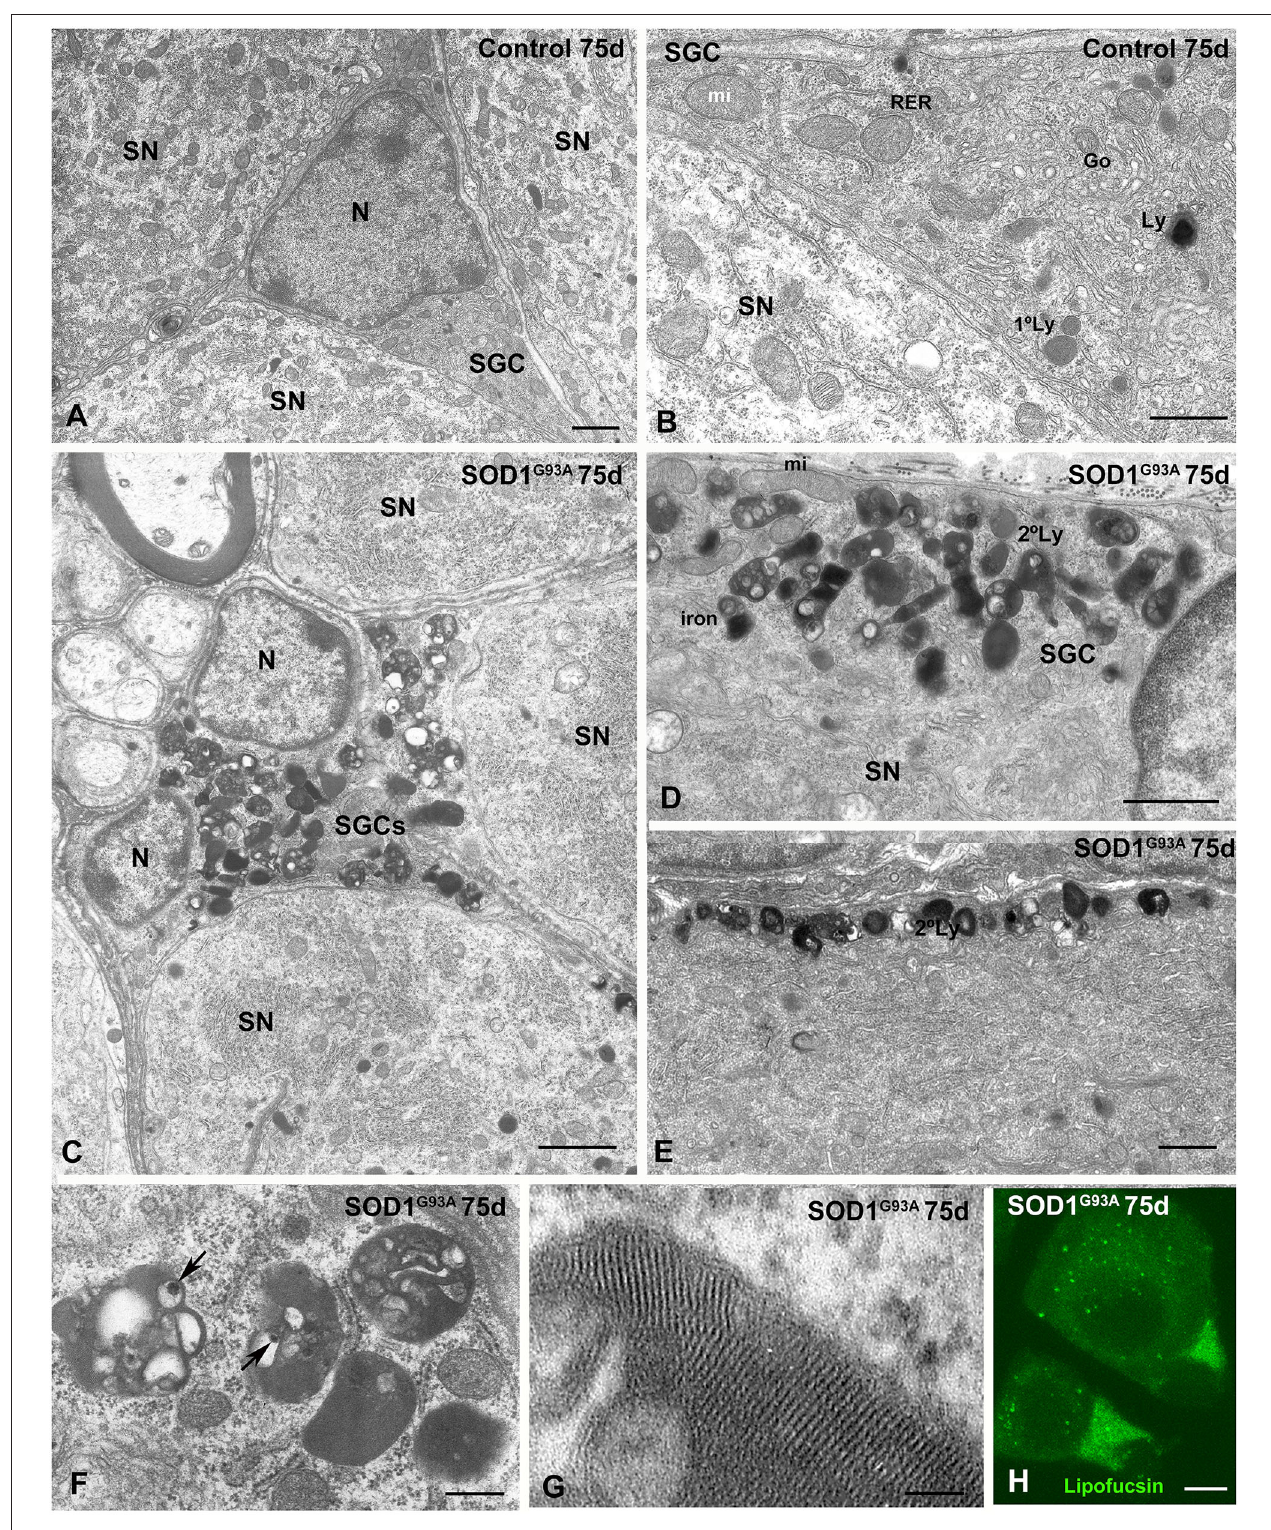
FIGURE 5 | Lysosomal storage disorder in SGCs from SOD1 G93 mouse at presymptomatic stage (75 days of age). (A,B) Ultrastructure of control SGSs surrounding sensory neurons (SN). Note in the (B) the characteristic organization of cytoplasmic organelles, including the Golgi complex (Go), endoplasmic reticulum,